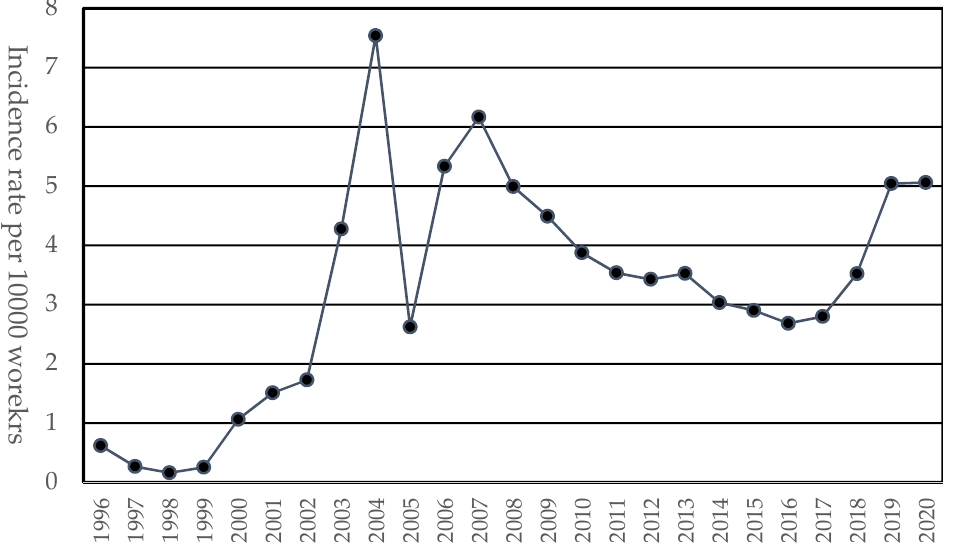
Figure 2. Incidence rates of WMSDs per 10,000 workers by year.